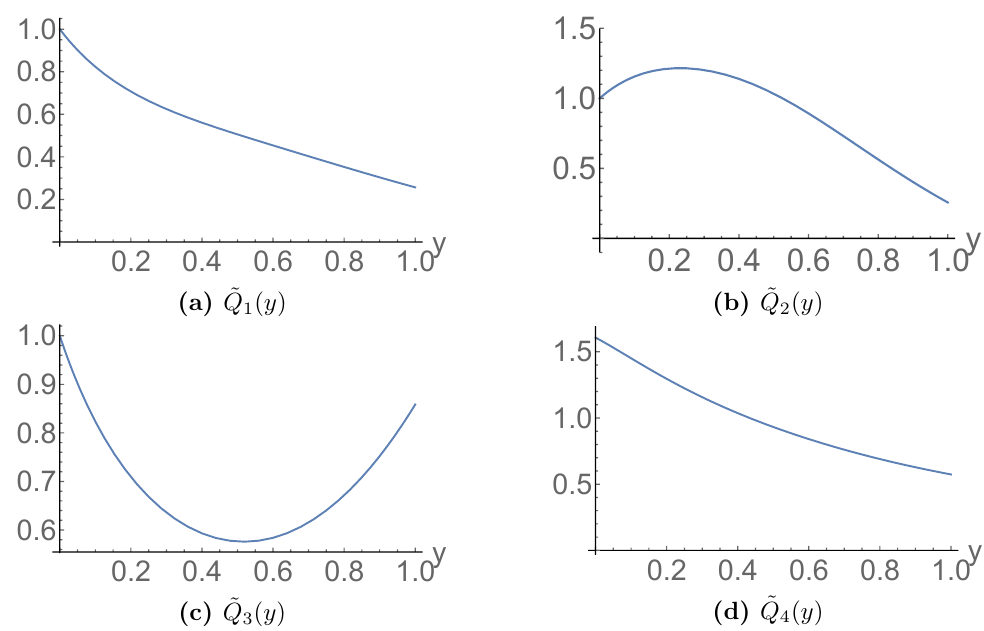
Figure 1. Solutions of the homogeneous system representing the boundary conditions imposed on the (cid:12)elds at x = 1 for q = L = n = 1, (cid:20) = (cid:0) 1, y + = 1 = 2. (cid:15) y =